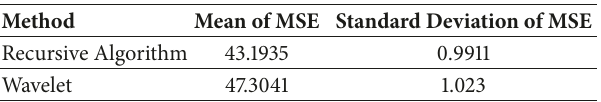
Table 3: Sensibility analysis considering a deviation in the cut-off